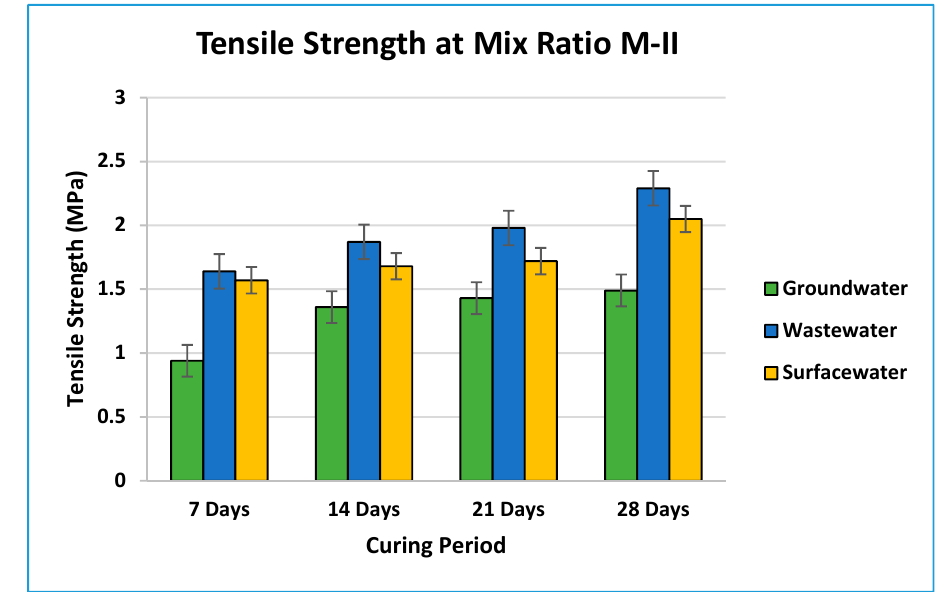
Figure 7. Split tensile strength of concrete for the ratio M-II (1:1.5:3).